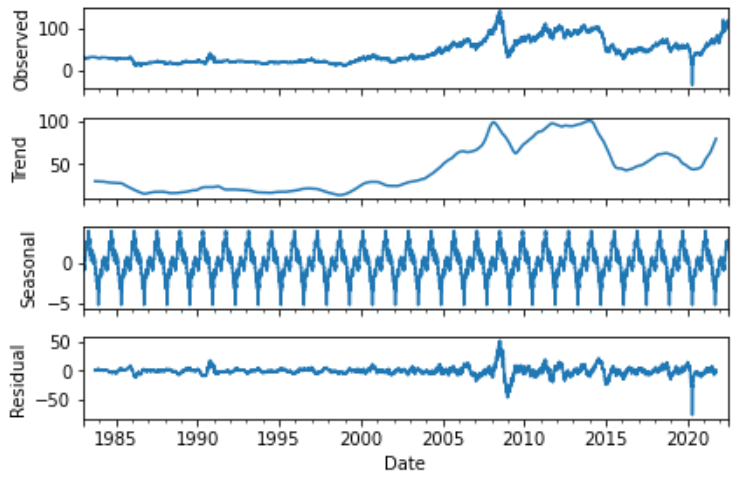
Figure 6. Time Series description.